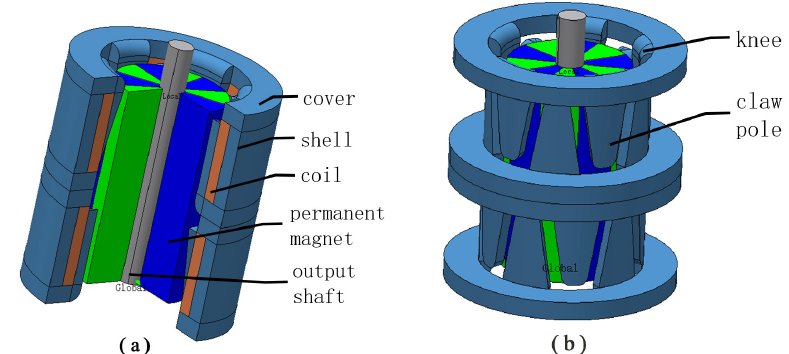
Figure 1. Structure diagram of a micro-claw permanent magnet stepper motor. ( a ) Overall schematic diagram of the motor. ( b ) The stator and permanent magnet rotor diagram of the motor.